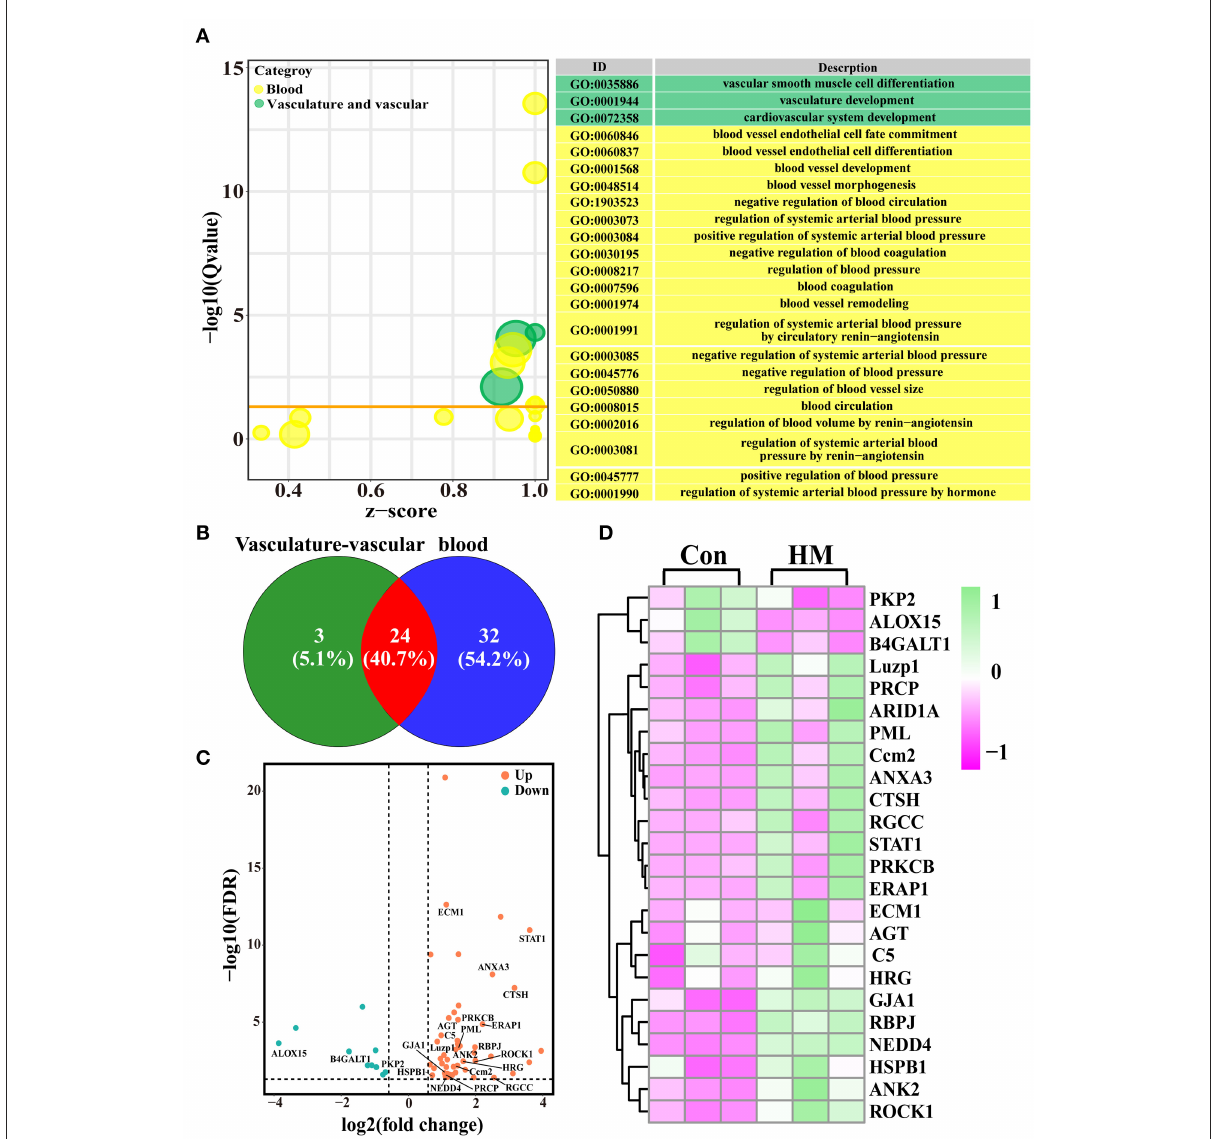
FIGURE3 The candidate DEPs selected from the 3,739 DEPs and GO terms related to angiogenesis. (A) the GO terms selected from the 819 significantly different biological processes related to blood, vascular or vasculature, and angiogenesis in the DIA data. (B) Venn diagram of the 59 DEPs related to blood and vasculature or vascular development. (C) Volcano plots of the 24 co-expressed DEPs. (D) Heat-map of the representative 24 co-expressed DEPs. Con, control group; HM, hemorrhagic mastitis